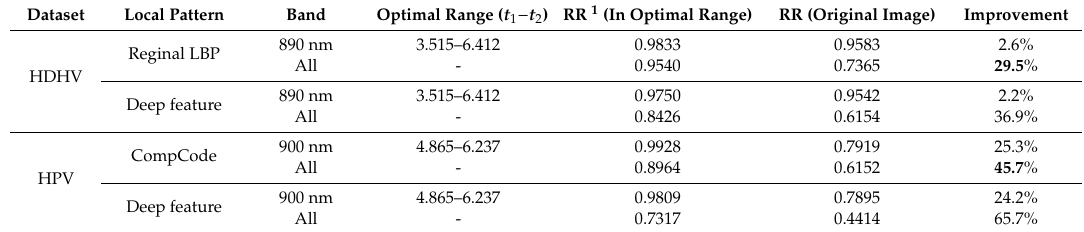
Table 1. Results on representative spectral from the hyperspectral